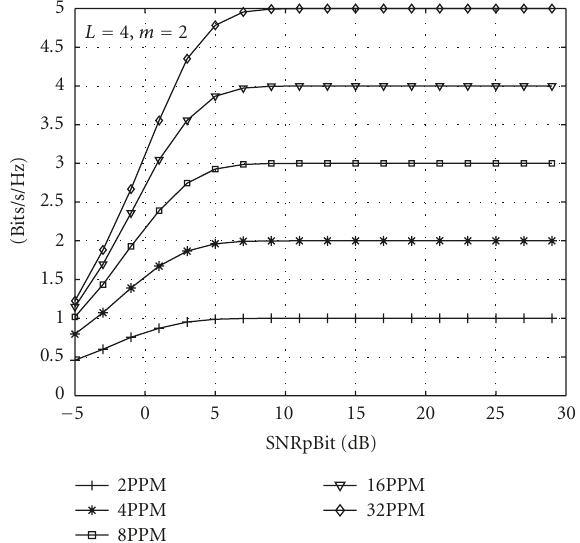
Figure 1: UWB multipath fading channel capacity with L = 4.